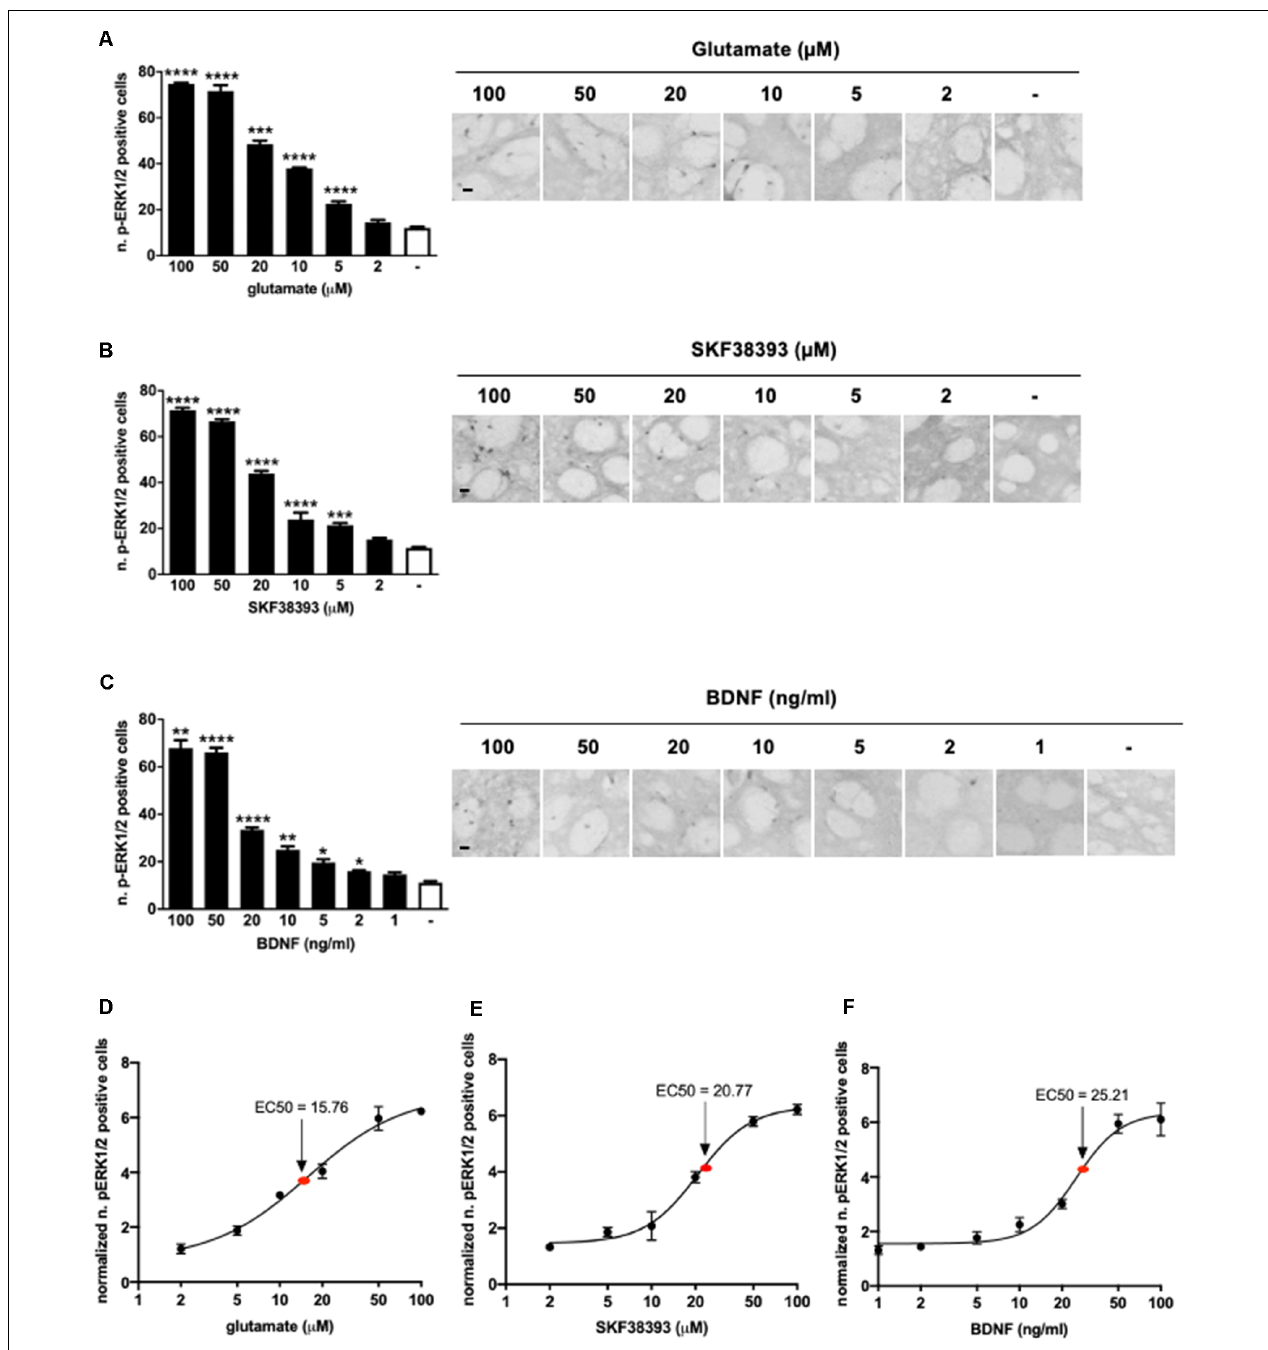
FIGURE 1 | (A) Glutamate induces significant extracellular-signal-regulated kinase (ERK) activation at doses ranging from 5 µ M to 100 µ M (one-way ANOVA, Welch’s F (6,9.064) = 1,001.854, p < 0.0001. Games Howell’s post hoc : comparisons were made between the not stimulated condition and each glutamate dose: **** p < 0.0001, *** p < 0.001). Data are shown as mean ± SEM, n = 4 per group. Scale bar: 50 µ m. (B) SKF38393 activates ERK at doses ranging from 5 µ M to 100 µ M (one-way ANOVA, F (6,27) = 320.491, p < 0.0001. Bonferroni’s post hoc : comparisons were made between the not stimulated condition and each SKF38393 dose: **** p < 0.0001, *** p < 0.001). Data are shown as mean ± SEM, n = 4 per group. Scale bar: 50 µ m. (C) Brain-derived neurotrophic factor (BDNF) activates ERK at doses ranging from 2 ng/ml to 100 ng/ml (one-way ANOVA, Welch’s F (7,9.911) = 134.027, p < 0.0001. Games Howell’s post hoc : comparisons were made between the not stimulated condition and each BDNF dose: **** p < 0.0001, ** p < 0.01, * p < 0.05). Data are shown as mean ± SEM, n = 4 per group. Scale bar: 50 µ m. (D–F) Dose-response curves of glutamate, SKF38393, and BDNF on ERK activation. Doses are reported on X-axis in a logarithmic (Log10) scale, whereas Y-axis shows the number of pERK1/2 positive cells normalized over not stimulated controls. The EC50 values were calculated using GraphPad Prism